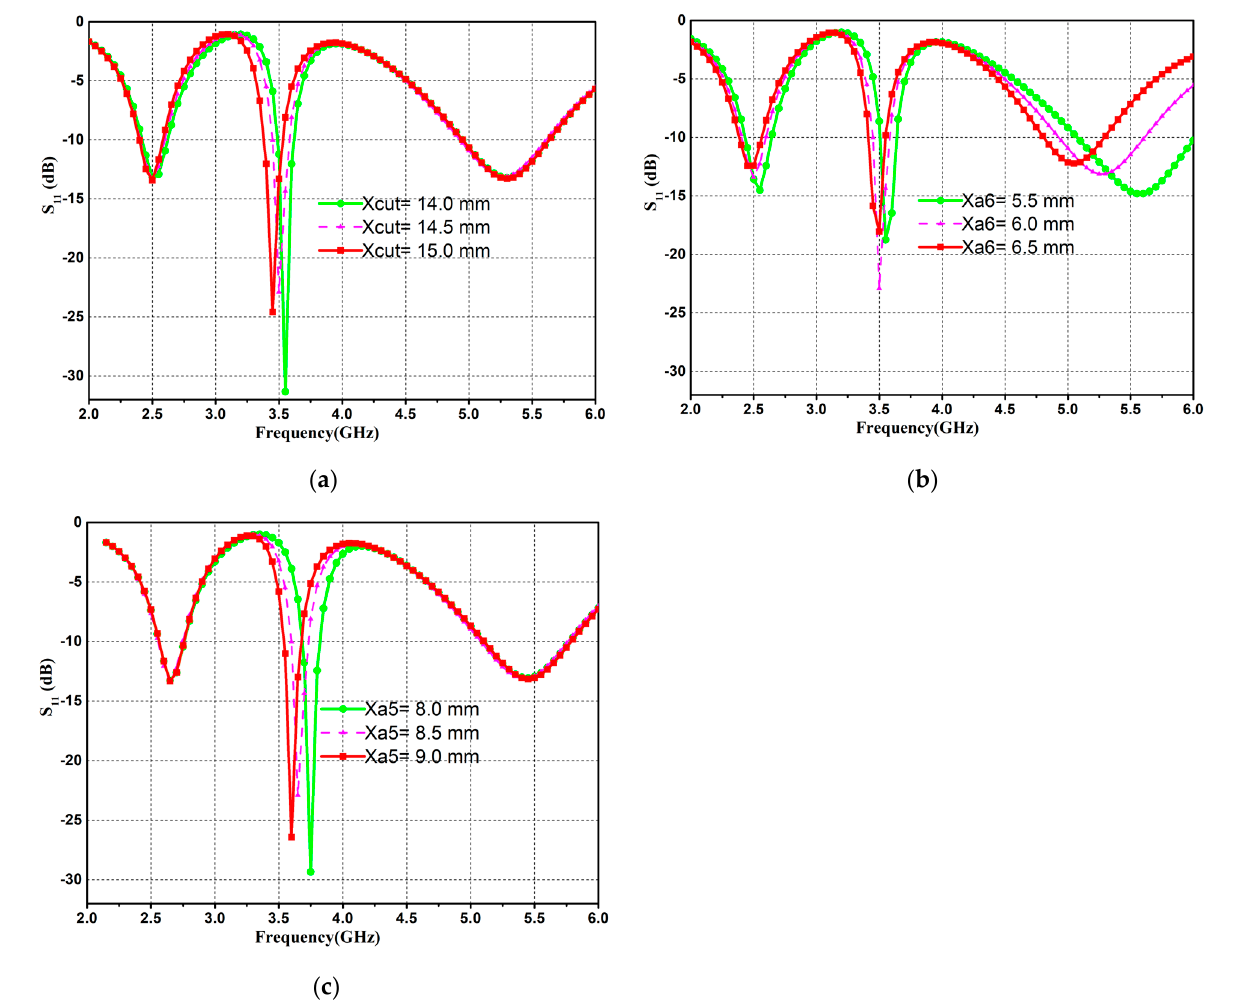
Figure 3. Parametric analysis of the antenna element: ( a ) X cut ; ( b ) X a 6 ; ( c ) X a 5 .